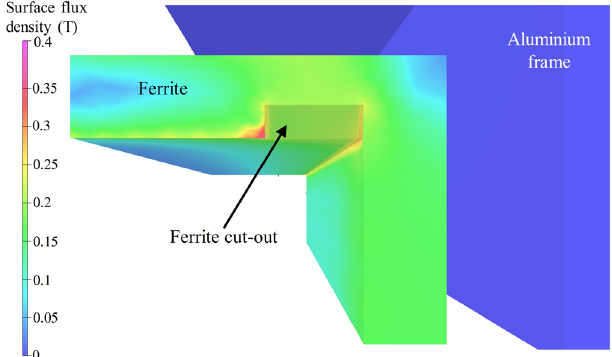
FIG. 7. Initial design of end ferrites, with cut-out to bend the saddle coils toward the aluminium frame (quarter of geometry shown). The color regions associated with the ferrite represent surface contours of predicted flux density, for a coil current of 240